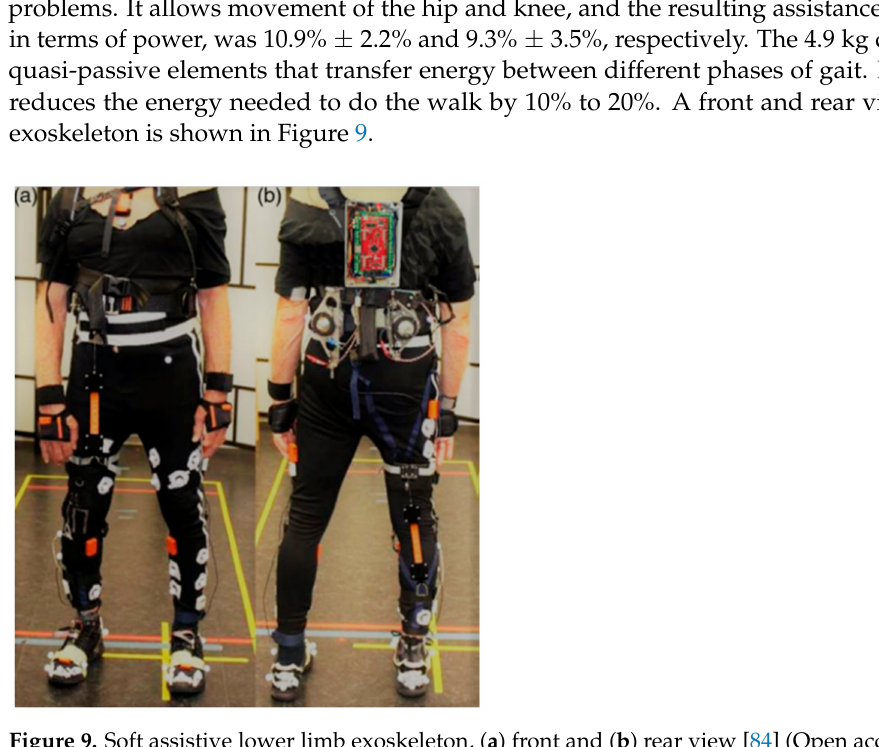
Figure 9. Soft assistive lower limb exoskeleton, ( a ) front and ( b ) rear view [84] (Open